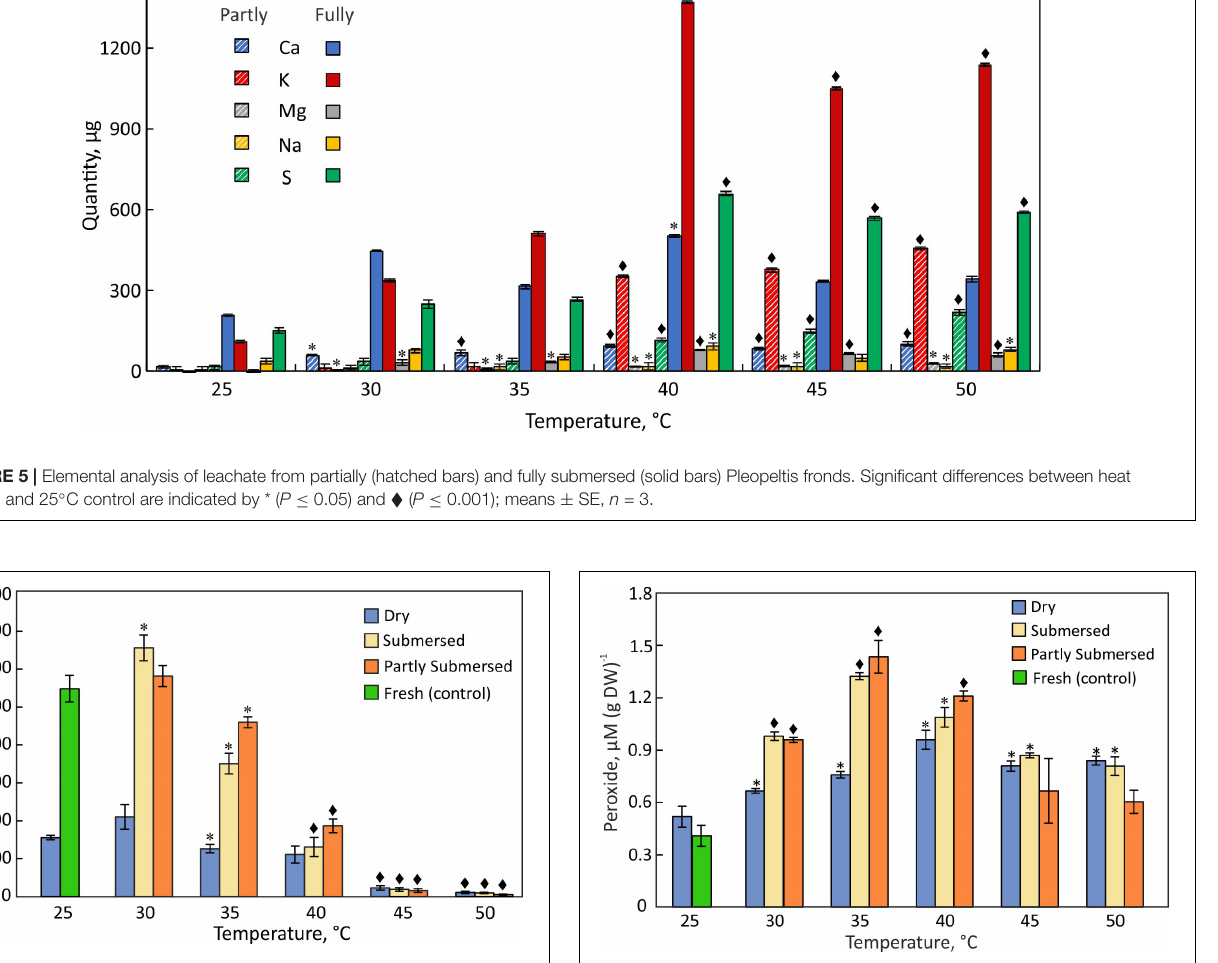
FIGURE 7 | Hydroperoxide content in dried, fully, or partly submersed Pleopeltis fronds exposed to various temperatures for 24 h. The content from heat treated dry and hydrated fronds is compared with 25 ◦ C dry and fresh (control), respectively. Significant differences between treated and controls are indicated by * ( P ≤ 0.05) and (cid:7) ( P ≤ 0.001); means ± SE, n =